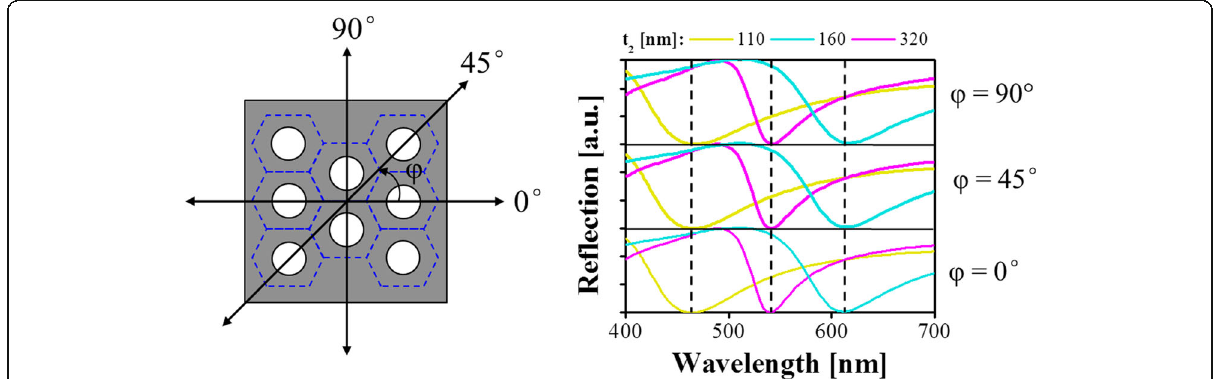
Fig. 3 Simulated reflection spectra of the proposed structure with respect to the incident